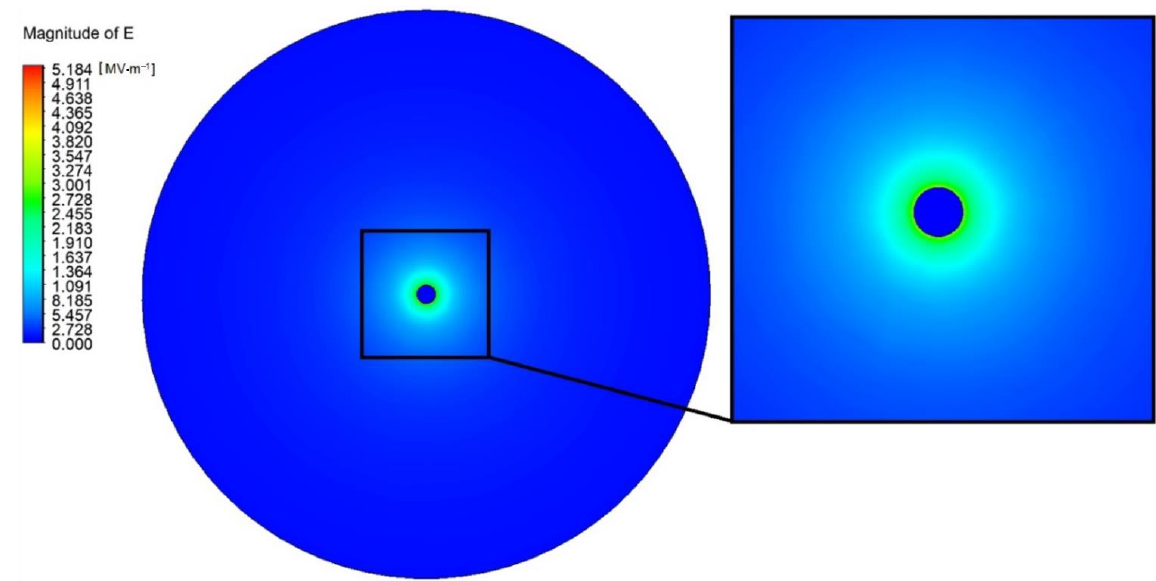
Figure 9. Range of electric field intensity on the electrode without spikes by numerical simulation.